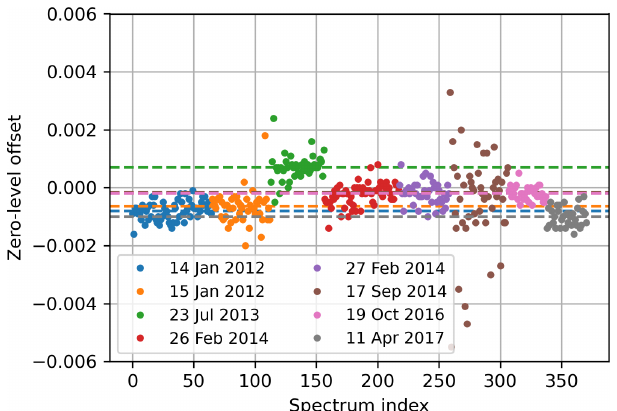
Figure F1. Zero-level offset retrieved from the Strong CO 2 window for the Lamont spectra coincident within ± 1h of the last AirCore sampling time and within ± 1.5h of the closest a priori time on each of the days indicated by the legend. The dashed lines mark the me- dian value for each